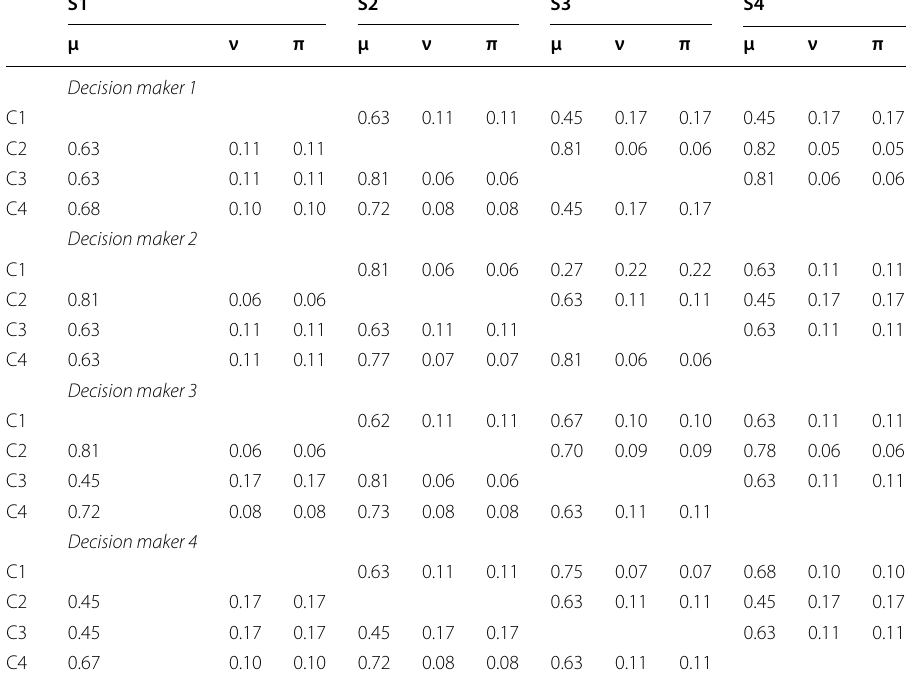
Table 18 Consensus-based membership, nonmembership, and hesitant degrees of spherical fuzzy sets for revenue sharing